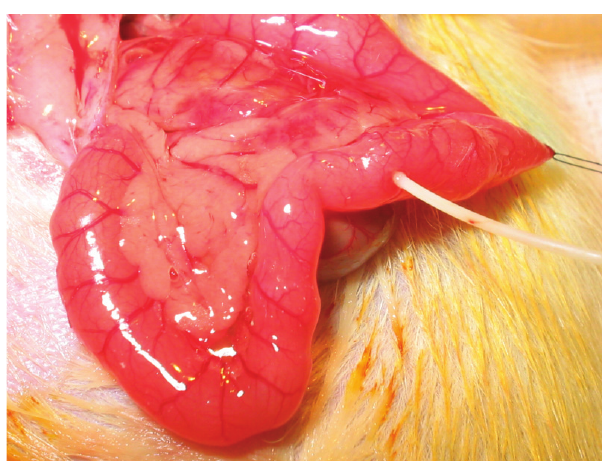
Figure 1- Injection of taurocholate into the main pancreatic duct